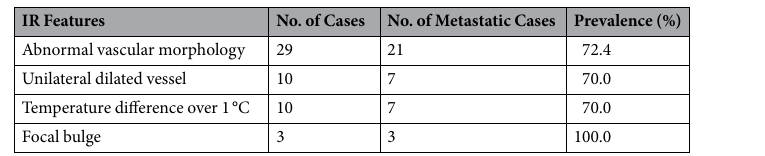
Figure 3. Structure of the EGSVM system. ( a ) The image in the black box is the cropped image from raw images, which is converted into a grayscale image; ( b ) The expanding process of win and feature extraction. The win expands from win 1 to win n . For win k , the entropy of Re image _ extraction process; ( c ) The red circles and blue squares represent high-dimensional feature vectors; ( d ) The structure of automatic analysis system for new raw images.